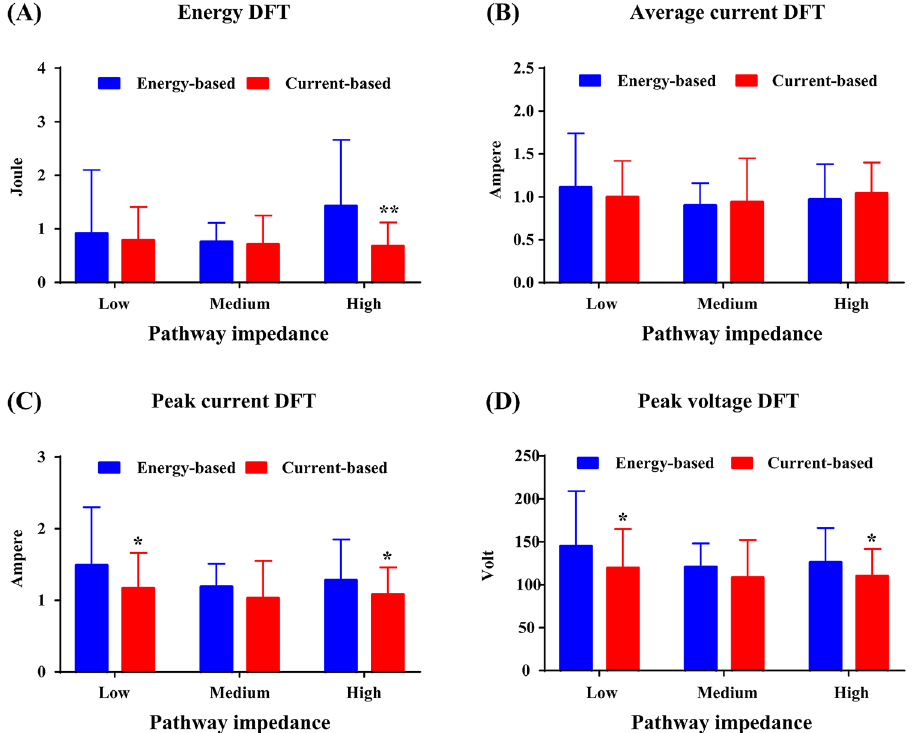
Figure 5. Energy defibrillation threshold (DFT) ( A ), the average current DFT ( B ), the peak current DFT ( C ) and the peak voltage DFT ( D ) for current-based and energy-based defibrillation at different pathway